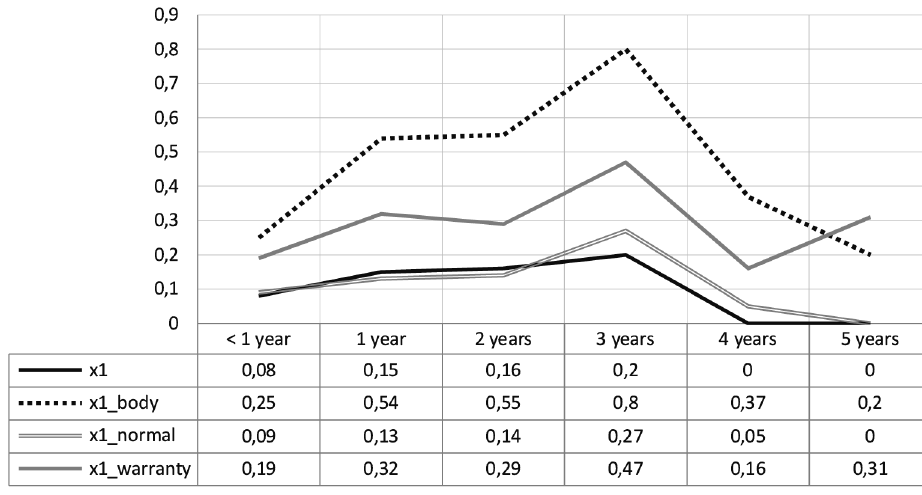
Source: own elaboration of the research conducted in 2018−2019. Figure 7. Summary of the SOSE retention index in 2018 for the brand x CUS account the years of vehicle use and division into the repair order types